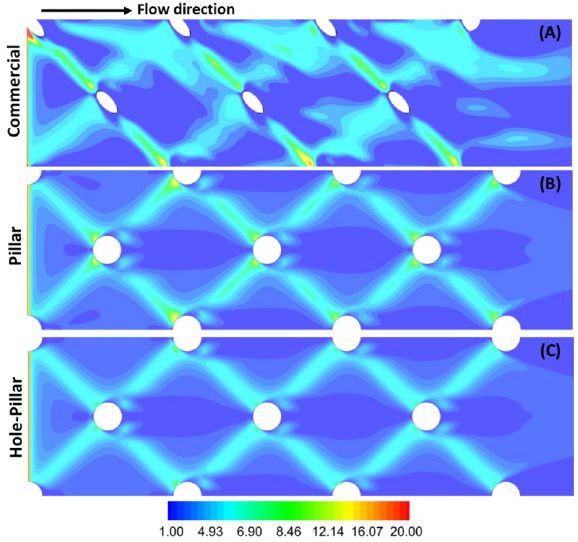
Figure 6. Calculated shear stress distribution on the bottom wall of the filtration channel. The commercial spacer has asymmetric stress distribution with the highest shear stress under the filament. Pillar and hole-pillar spacer have symmetric stress distribution, and lower shear stress value is observed for the hole-pillar